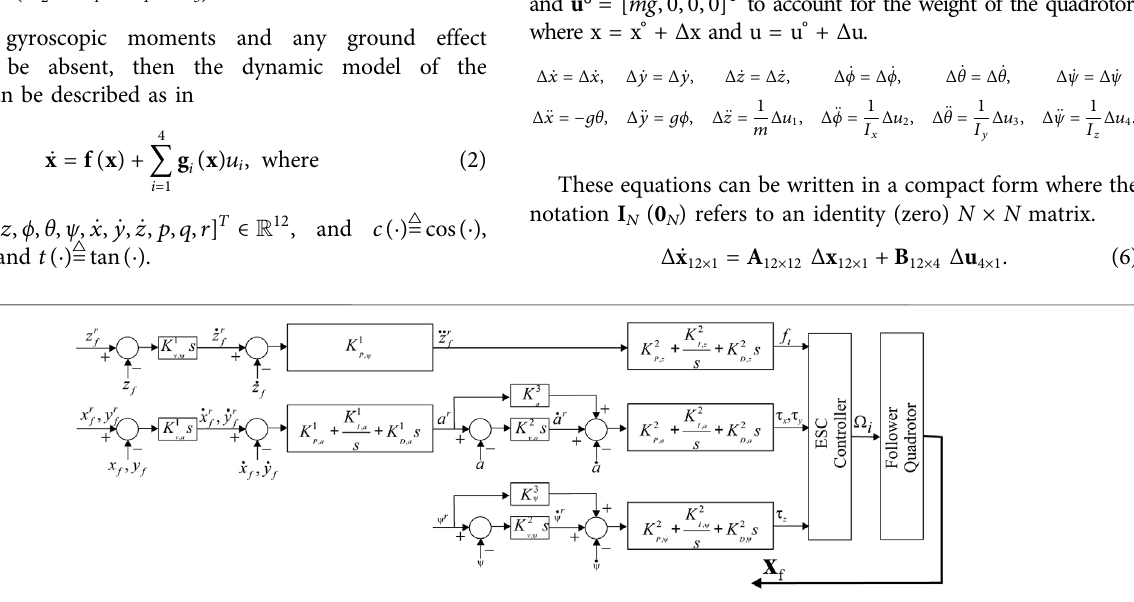
FIGURE 5 | Ardupilot-based controller design for single